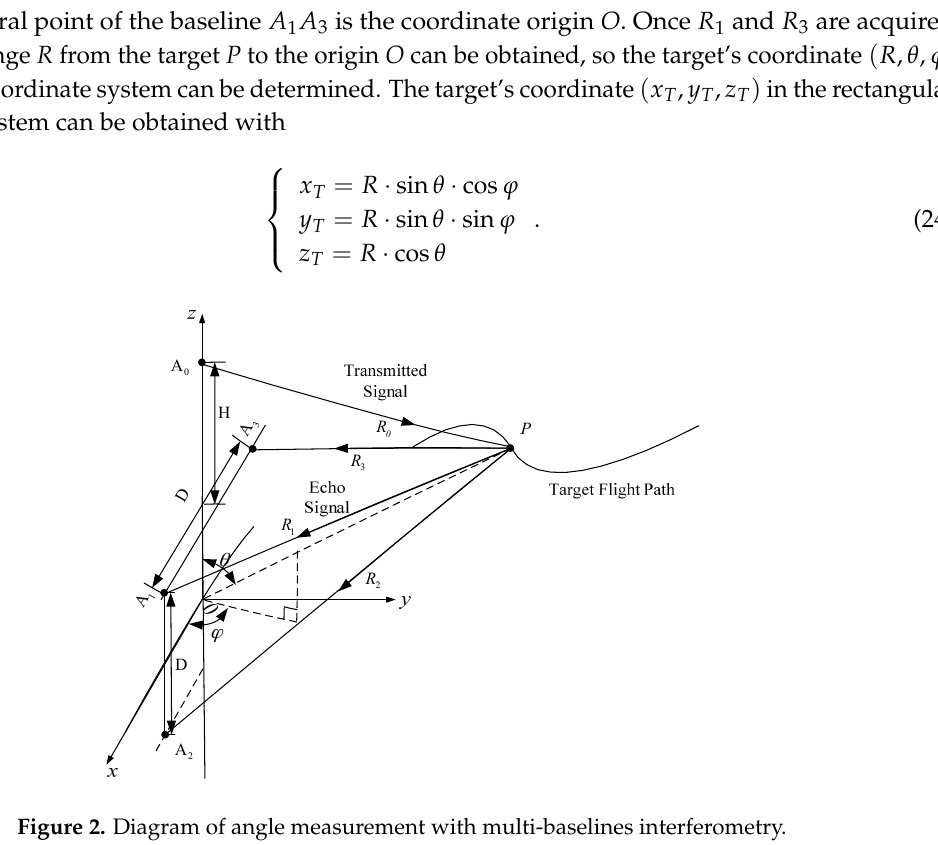
Figure 2. Diagram of angle measurement with multi-baselines interferometry.